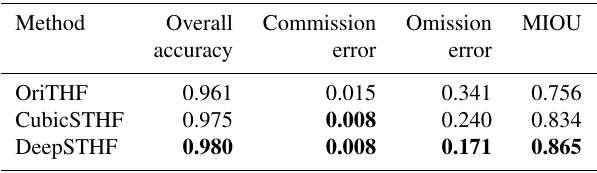
Table 1. The lead mapping results of the three